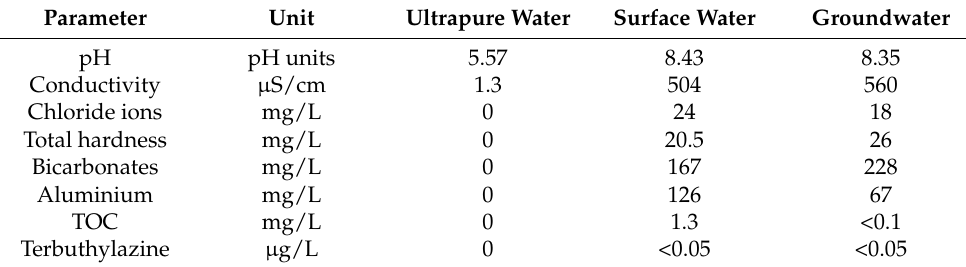
Table 1. Physico-chemical characteristics of the studied